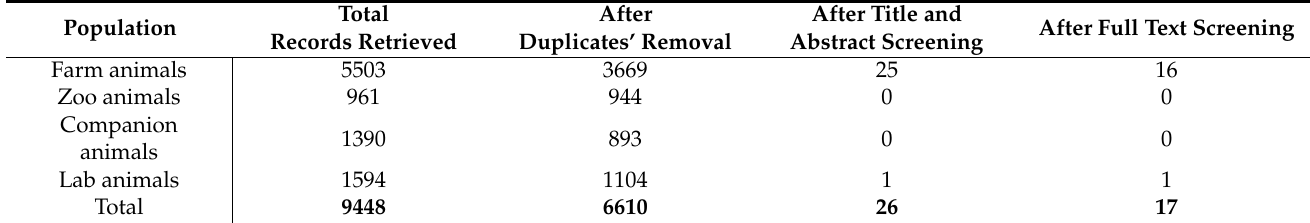
Table 2. List of records included in all stages of the systematic review for farm animals, zoo animals, companion animals, and lab